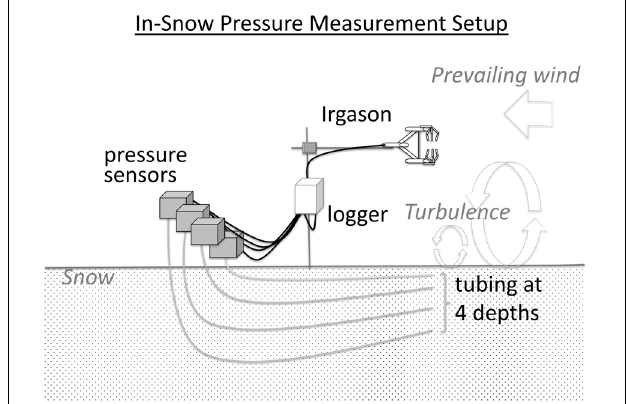
FIGURE 2 | Schematic of the experimental setup. Pressure sensors measure at 4 depths in the snow through flexible tubing. A Campbell Scientific Irgason mounted ∼ 1 m above the snow measures 3D wind components at 20 Hz. Data are stored on a CR-3000 logger mounted on the low-profile